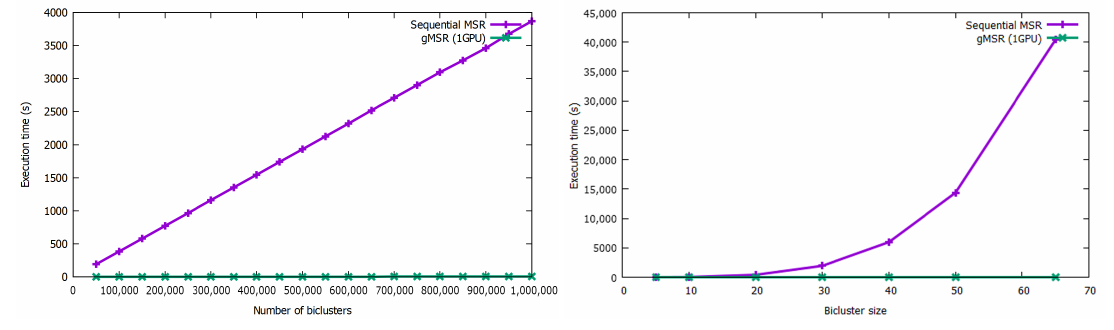
Figure 4. This figure includes two graphs that measure the execution rates in seconds for the sequential version and single-GPU mode when processing synthetic bicluster datasets. The graph on the left shows the results when the number of biclusters increase but its size is fixed. The graph on the right shows the execution times when the size of the biclusters increases. In both test, the single-GPU version behaves nearly in a constant